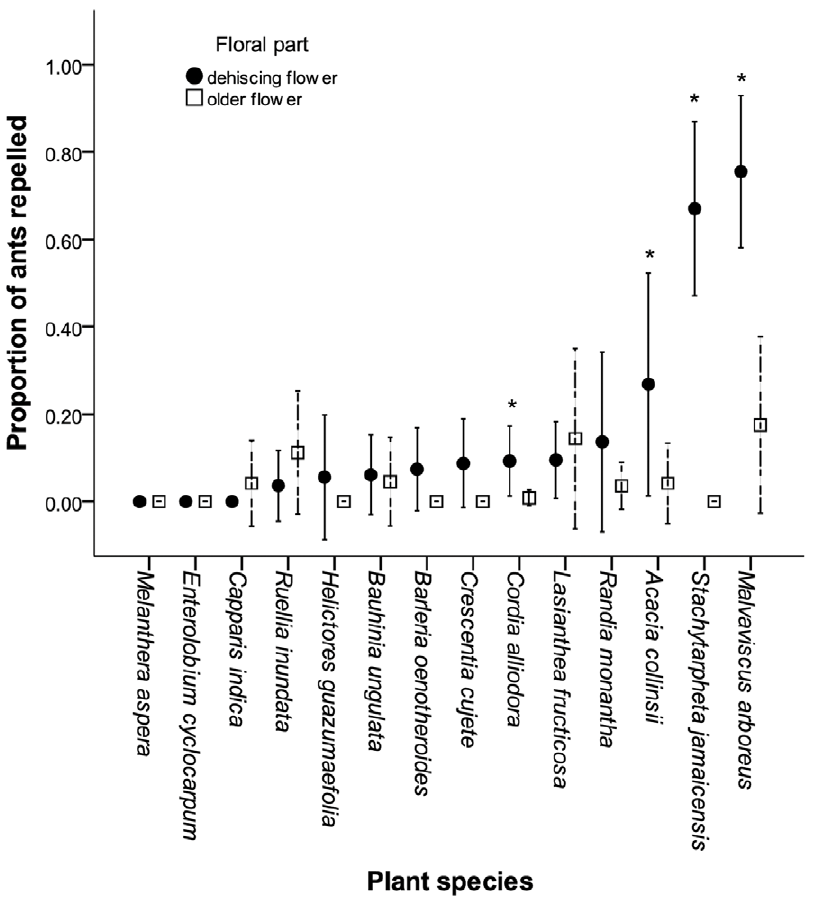
Figure 3. Plant species tested for tactile ant repellence with Ectatommaruidum . * indicates significant difference between freshly dehisced flowers and old pollen-depleted flowers. Error bars indicate 95% confidence intervals.